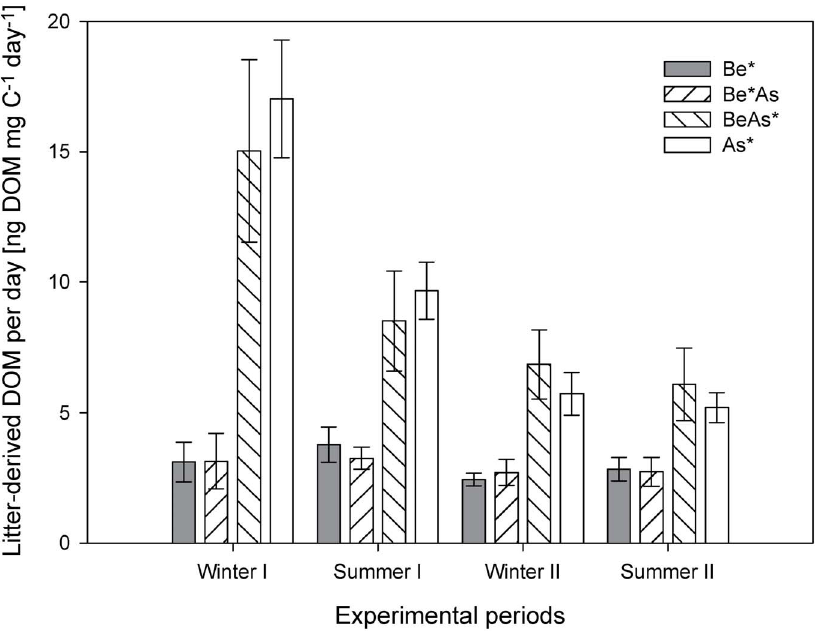
Figure 2. Calculated average daily release of litter-derived DOM (mean + standard error; n 5 6) for the pure and mixed labeled (*) treatments of beech (Be) and ash (As) in the different winter (I: 30.03.09; II: 21.12.09–22.03.10) and summer periods (I: 20.04.09–30.11.09; II: 07.04.10–31.05.10).